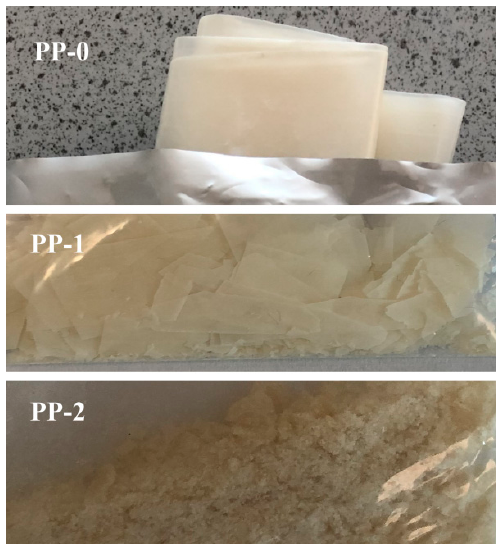
Figure 2. Images of the polypropylene (PP) samples used as additional carbon sources for polyhydroxyalkanoate (PHA) production. PP-0 was the original sample received and PP-1 and PP-2 were treated thermally.